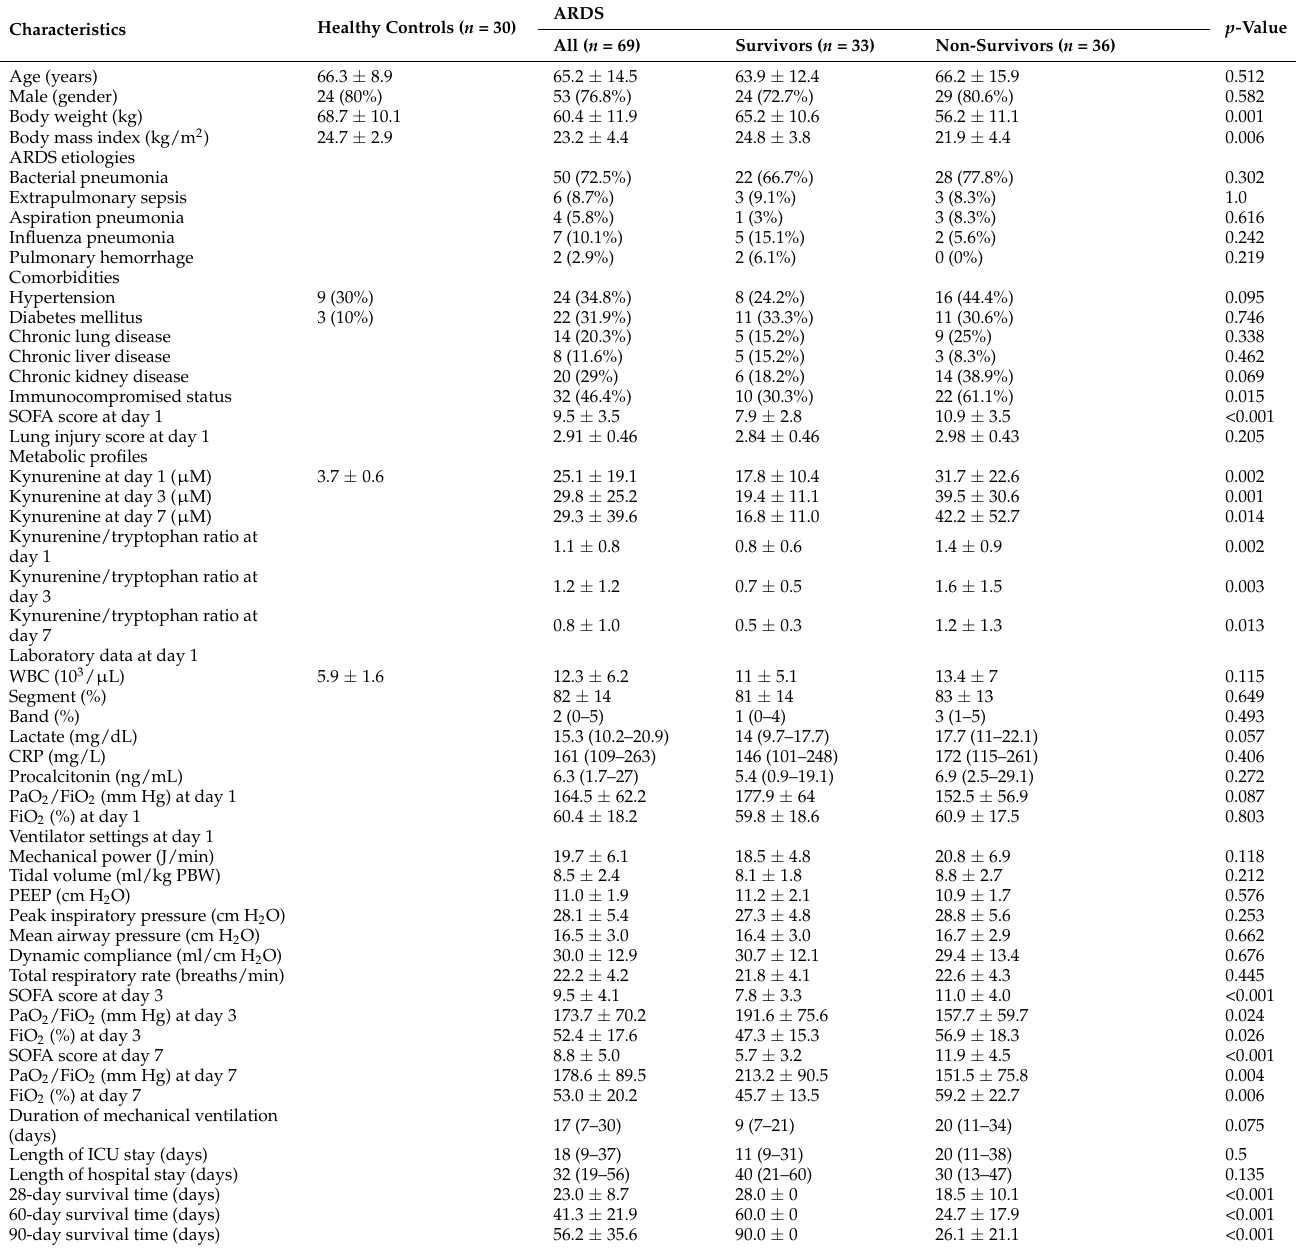
Table 1. Background characteristics and clinical and metabolic variables: healthy controls and ARDS